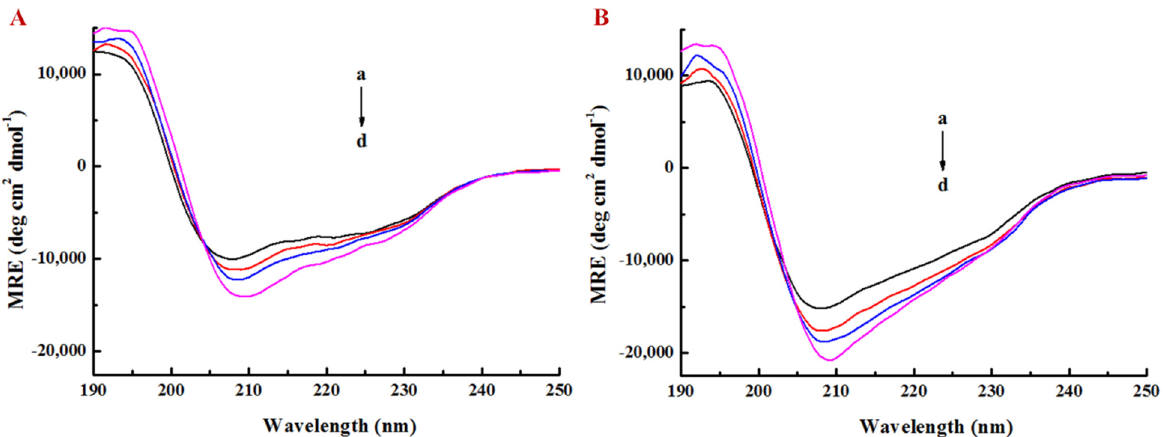
Figure 5. Far-UV CD spectra of ( A ) lysozyme and ( B ) lysozyme/pectin nanoparticles with lysozyme/pectin mass ratio of 1:1 in the presence and absence of EGCG at pH 7.0, [EGCG] = 0.1 mg/mL. The EGCG/lysozyme molar ratio was (a–d) 0:1, 1:1, 2:1, and 4:1.